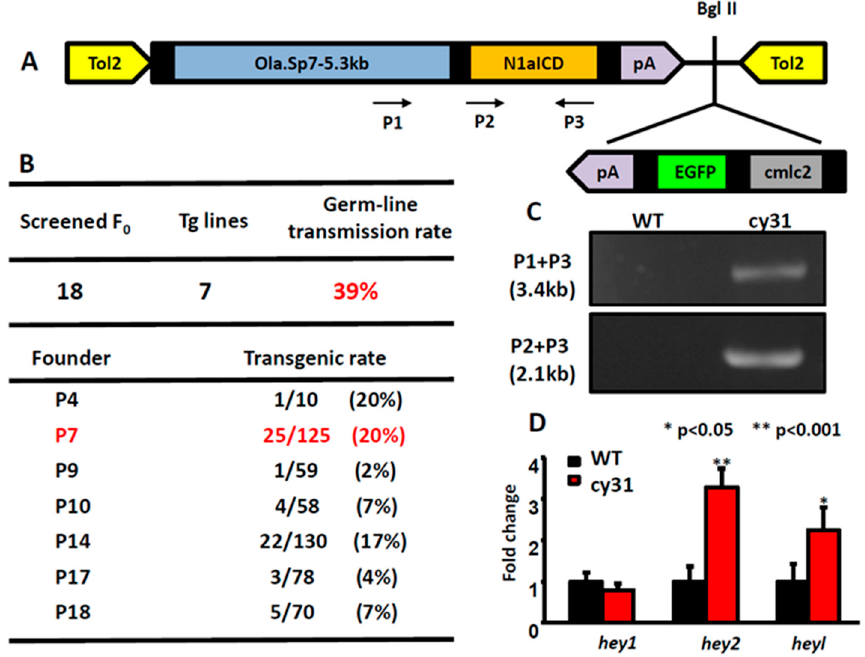
Figure 1. Generation of Tg(Ola.Sp7:N1aICD) cy31 transgenic fish. ( A ) Schematic diagram of vector (pDestTol2CG2-Ola.Sp7-N1aICD-pA), in which notch1a ICD (N1aICD) was driven by the medaka fish osteoblast specific promoter Sp7 and linked with EGFP , driven by cmlc2 , a heart-specific promoter. ( B ) Genotyping to confirm the transgenic rate in different founder fish. Founder fish number 7 (P7) with high germ-line transmission rate was used to generate F1 progeny (labeled with red color). ( C ) Agarose gel electrophoresis validated N1aICD construction in the transgenic fish line Tg(Ola.Sp7:N1aICD) cy31 . Genomic DNA from caudal fin was used as the template. PCR product was expected to have a size of 3.4 kb or 2.1 kb with primer P3 paired with P1 or P2, respectively. ( D ) Significant up-regulation of hey2 and heyl expressions in Tg(Ola.Sp7:N1aICD) cy31 transgenic fish was observed by real time RT-PCR. (averages ± SD; * p < 0.05; ** p < 0.001; *** p < 0.005; n = 10).